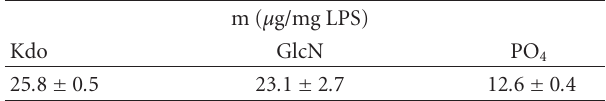
Table 2: The quantity of Kdo and GlcN i phosphates (PO 4 ) in LPS of D. desulfuricans intestinal strain